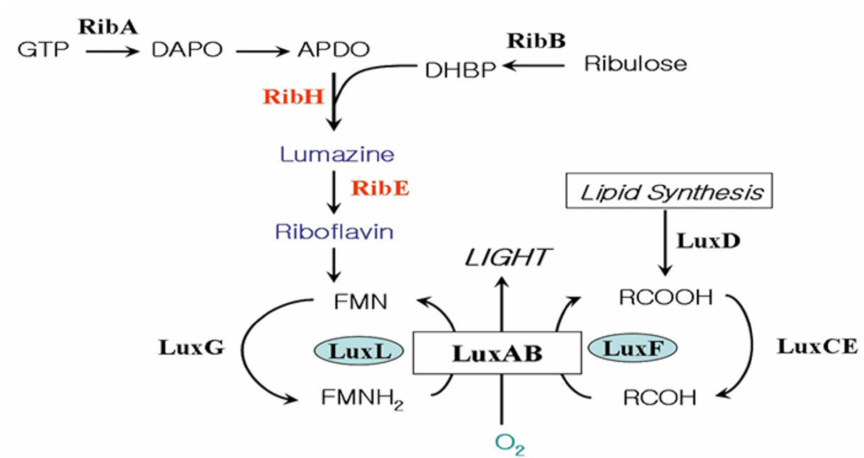
Figure 1. The genes involved in bacterial bioluminescence reaction of Photobacterium species. The functions of the gene products are as follow: luciferase (LuxAB), fatty acid reductase complex (LuxCDE), non-fluorescent flavoprotein (LuxF), flavin reductase (LuxG), lumazine protein (LuxL), GTP cyclohydrolase II (RibA), dihydroxy-butanone 4-phosphate synthase (RibB), lumazine synthase (RibH), and riboflavin synthase (RibE).